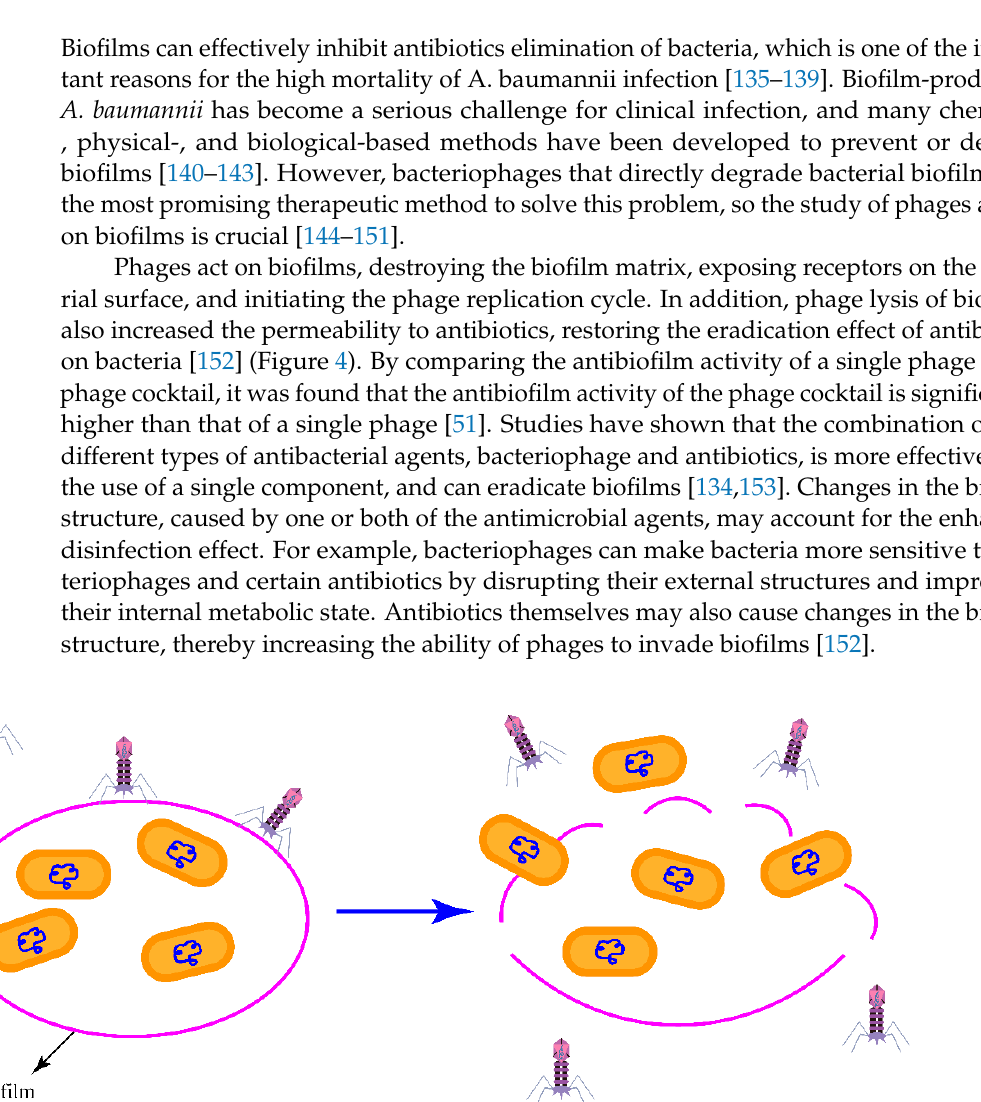
bacteriophage protein antimicrobials work better with antibiotics. In the clinical